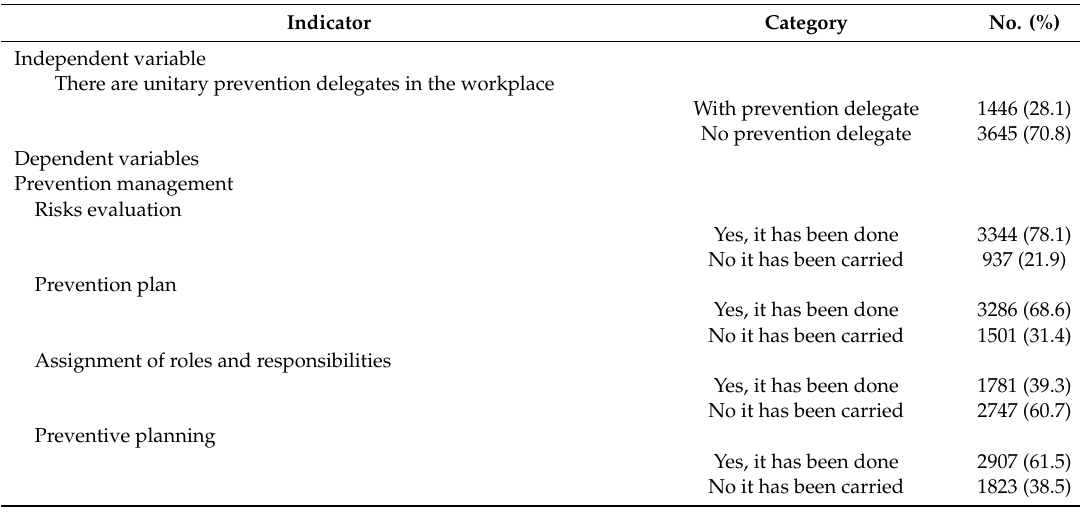
Table A1. Descriptive analysis of the